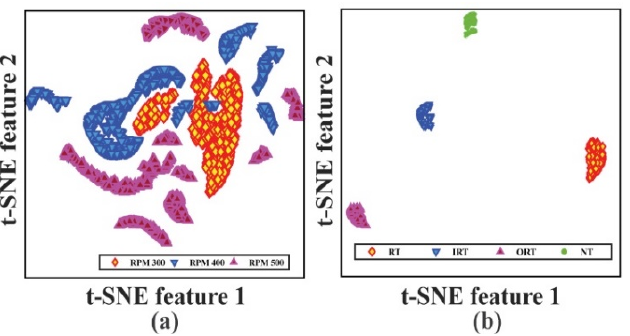
Figure 11. Feature space of the output layers by t-SNE: ( a ) Task 1: speed detection, and ( b ) Task 2: health type detection. Table 3. Diagnostic performance of the dataset.